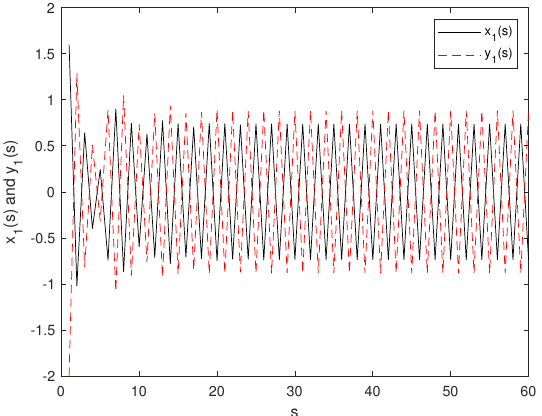
Figure 3. Trajectory curves of x 1 ( s ) and y 1 ( s ) without controller.